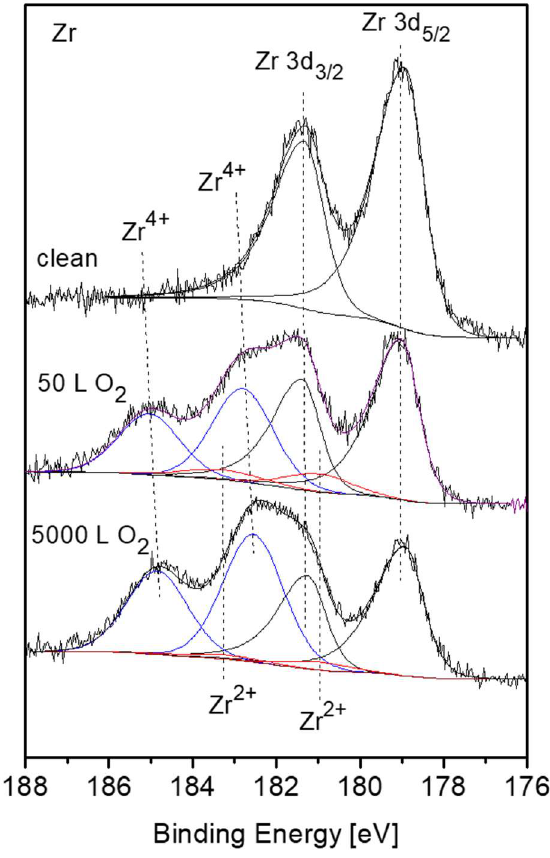
Figure 6. Representative XPS Zr 3d spectra, after different exposures at room temperature, with fitted metallic and oxide (Zr 4+ – blue, Zr 2+ – red) components.